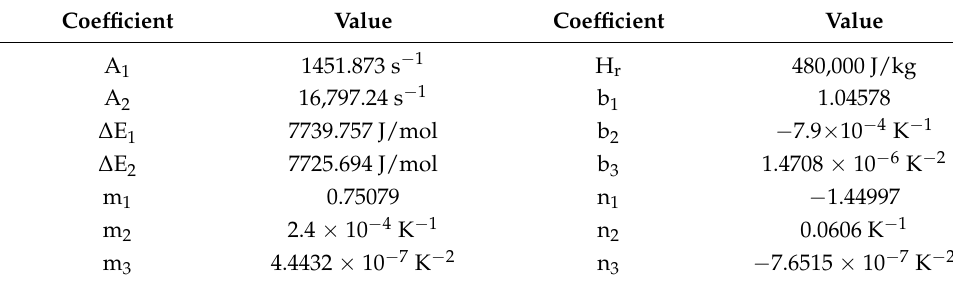
Table 2. Coefficients values of the curing rate equation.